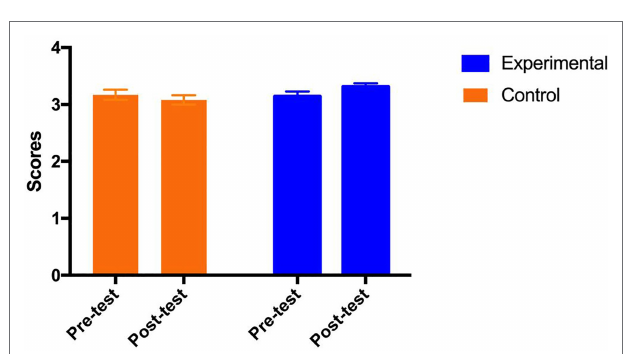
FIGURE 3 | Adjusted mean (SE) for flow state by group and